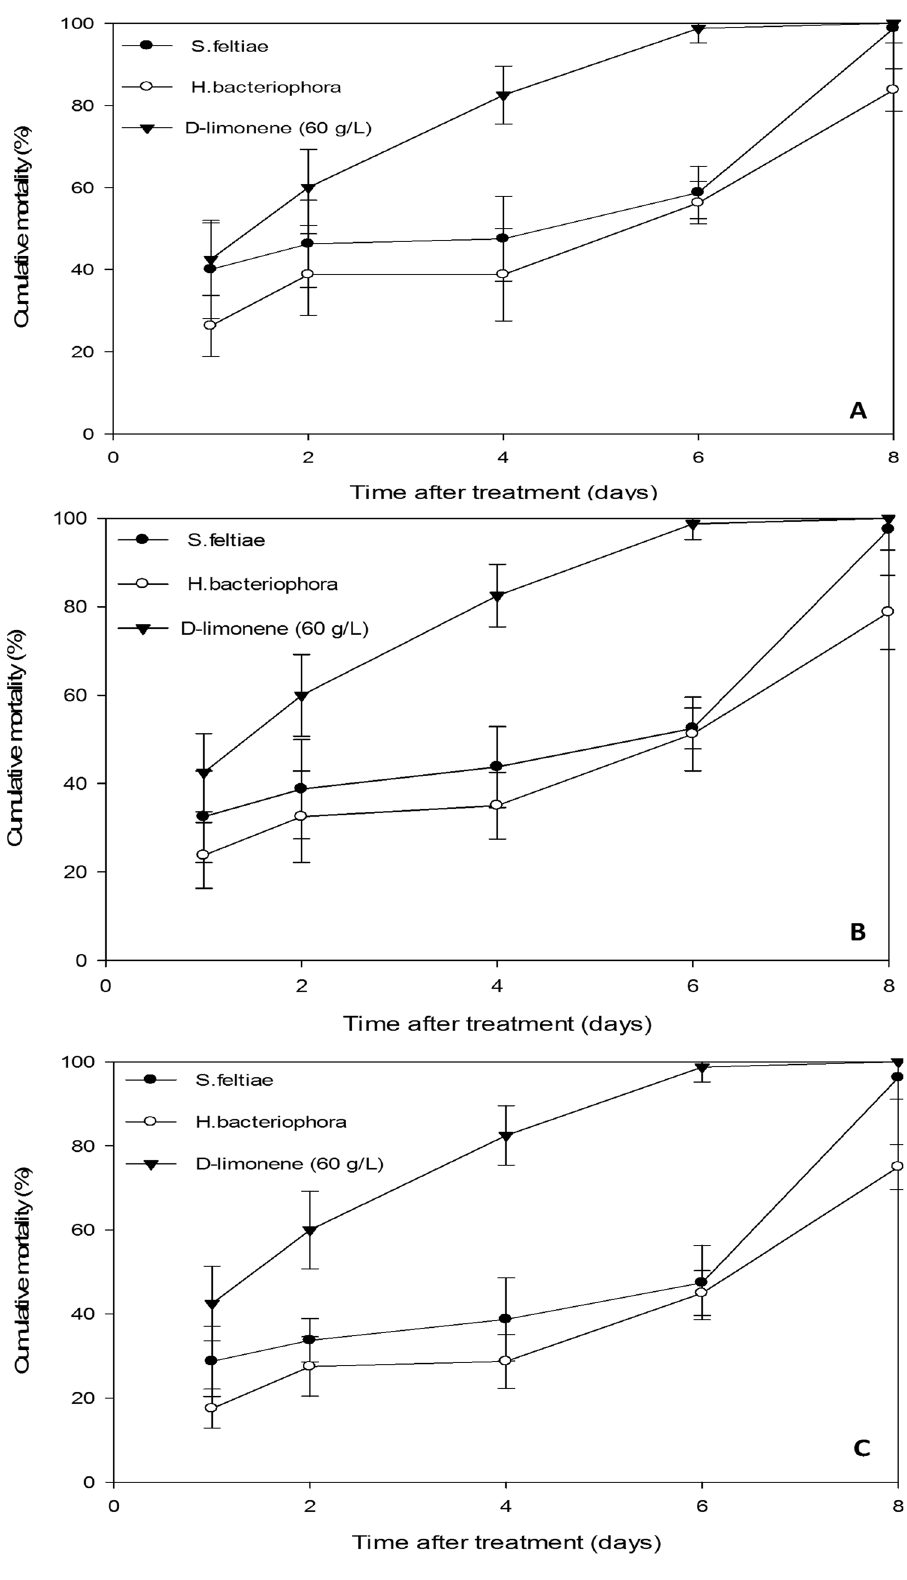
Figure 3. Cumulative mortality of Dactylopius opuntiae nymphs by Steinernema feltiae and Heterorhabditis bacteriophora with different concentrations ( A —75, B —50, C —25 IJs cm −2 ) according to days after treatment. Vertical bars indicate standard